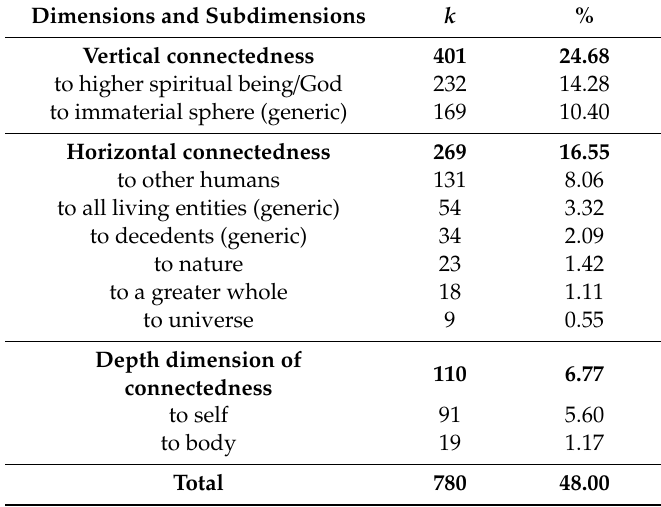
Table 2. Of the frequency analysis of dimensions and subdimensions of spirituality according to Bucher’s model (K = 1625).